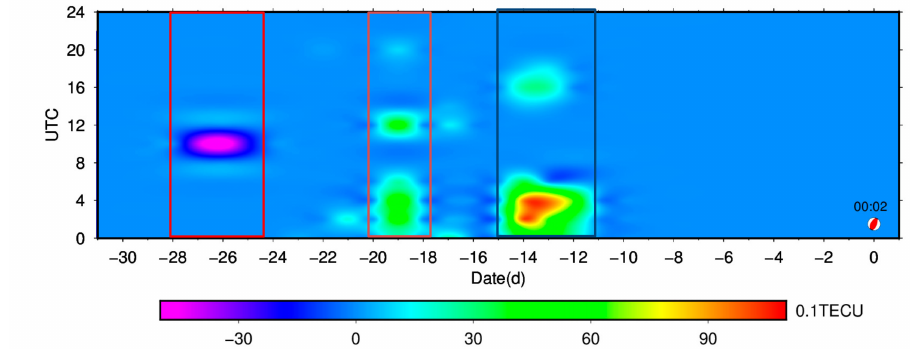
Figure 5. Analysis on total electron contents (TECs) over the epicenter from 21 March to 20 April 2013 (UTC) in which the focal sphere represents the shock time.